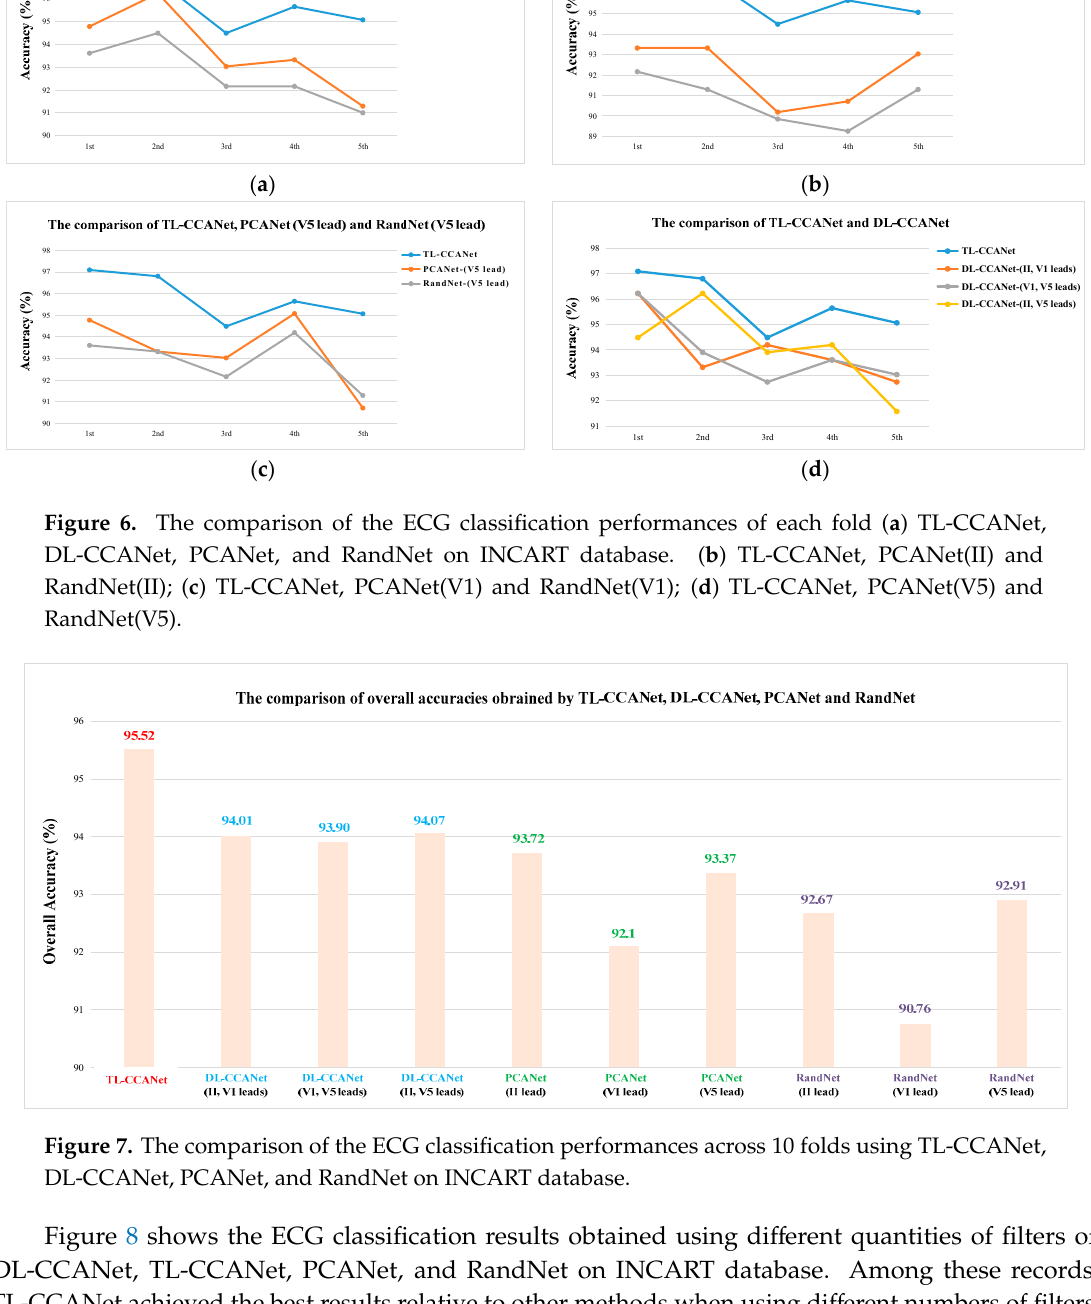
Figure 7. The comparison of the ECG classification performances across 10 folds using TL-CCANet, DL-CCANet, PCANet, and RandNet on INCART database.